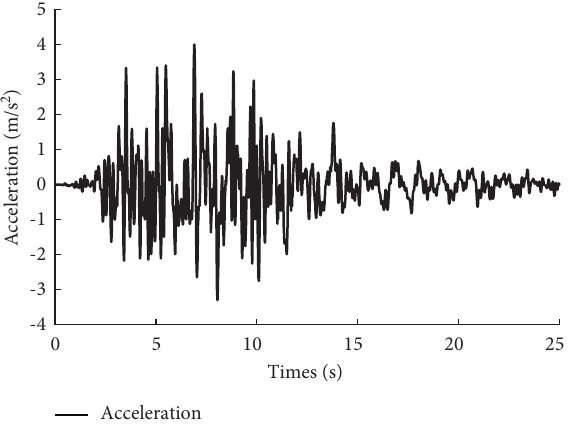
Figure 6: Seismic acceleration-time history curve. Table 4: Calculation